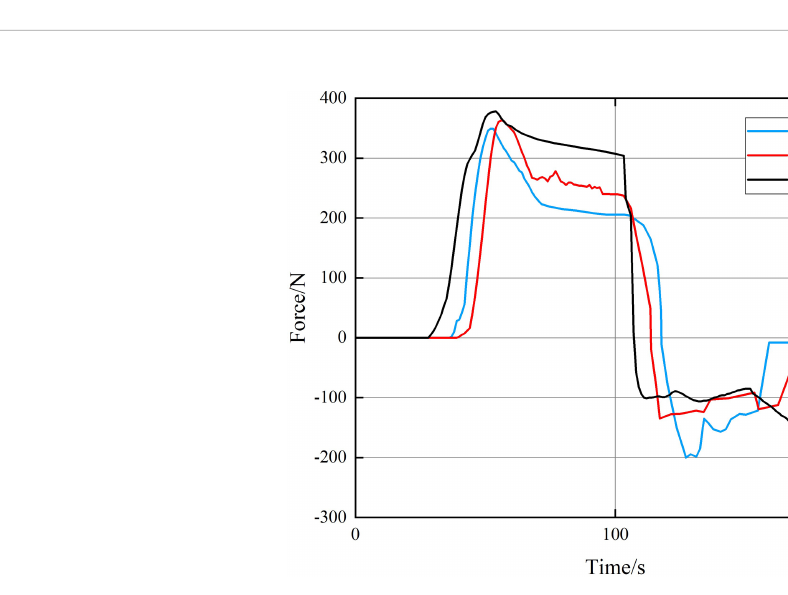
FIGURE 11 Penetration resistance in a tidal fl at